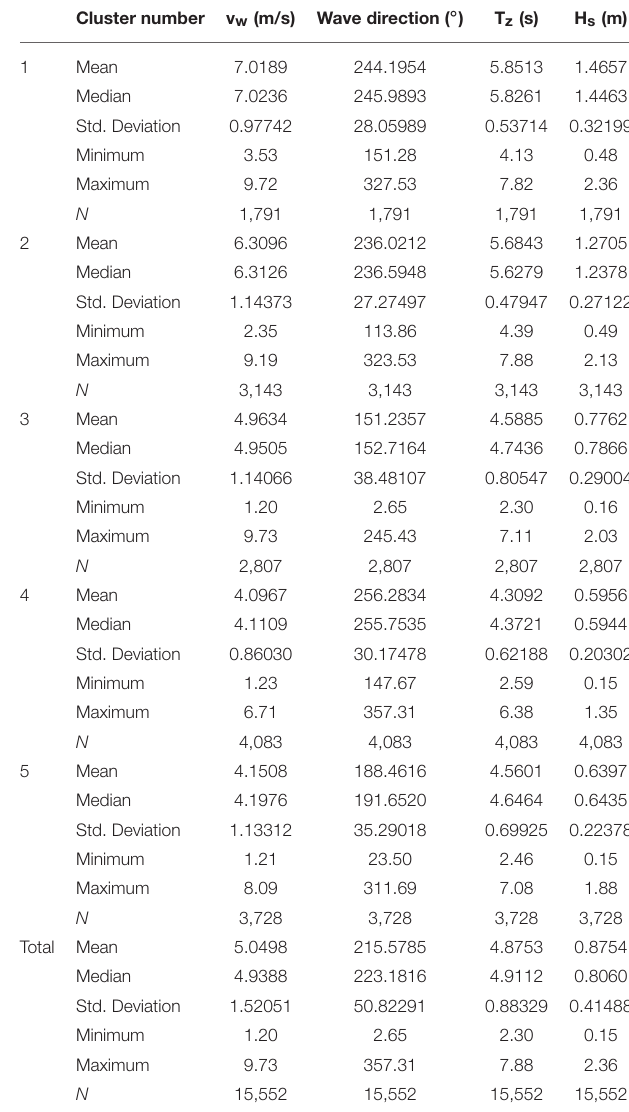
TABLE 4 | Summary of the descriptive statistics of meteo-climatic parameters in the five selected